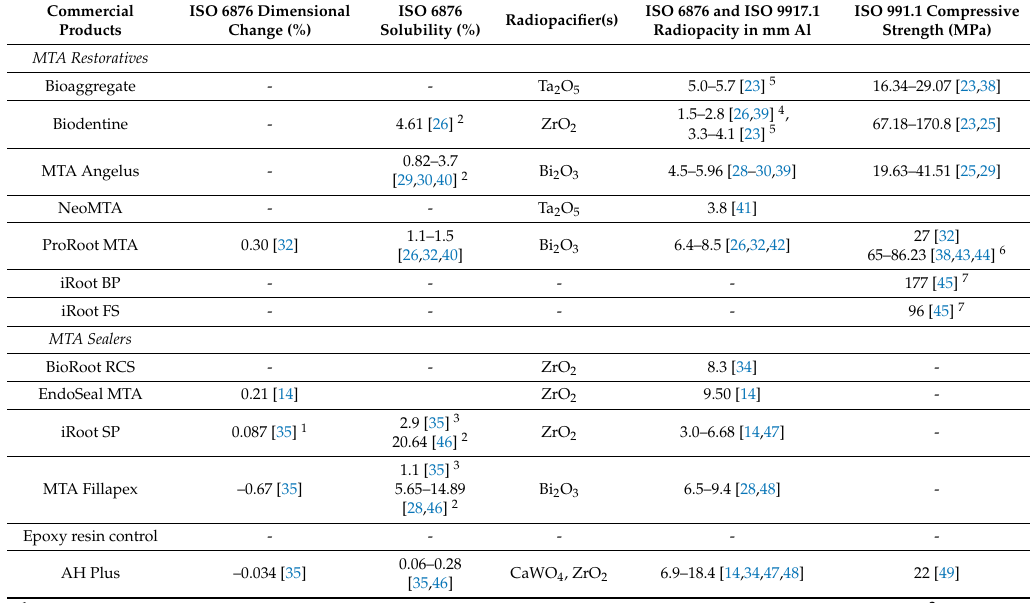
Table 4. Non-biological properties of MTA restoratives and sealers after